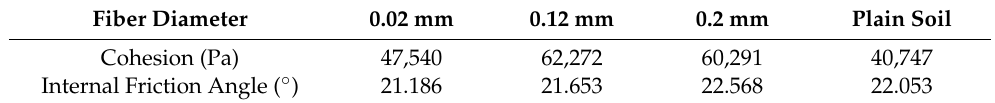
Table 2. Shear strength parameters of fiber